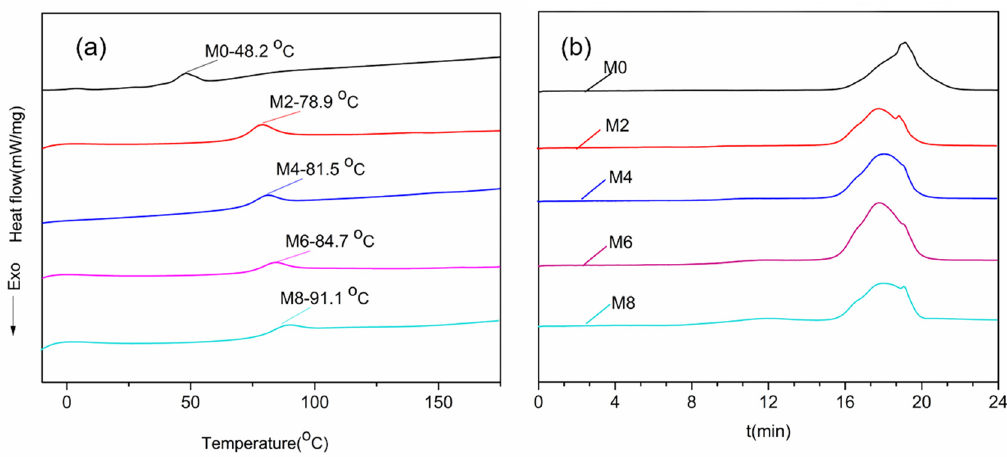
Figure 3. Curves obtained by DSC ( a ) and GPC ( b )for M-DCPD resin.